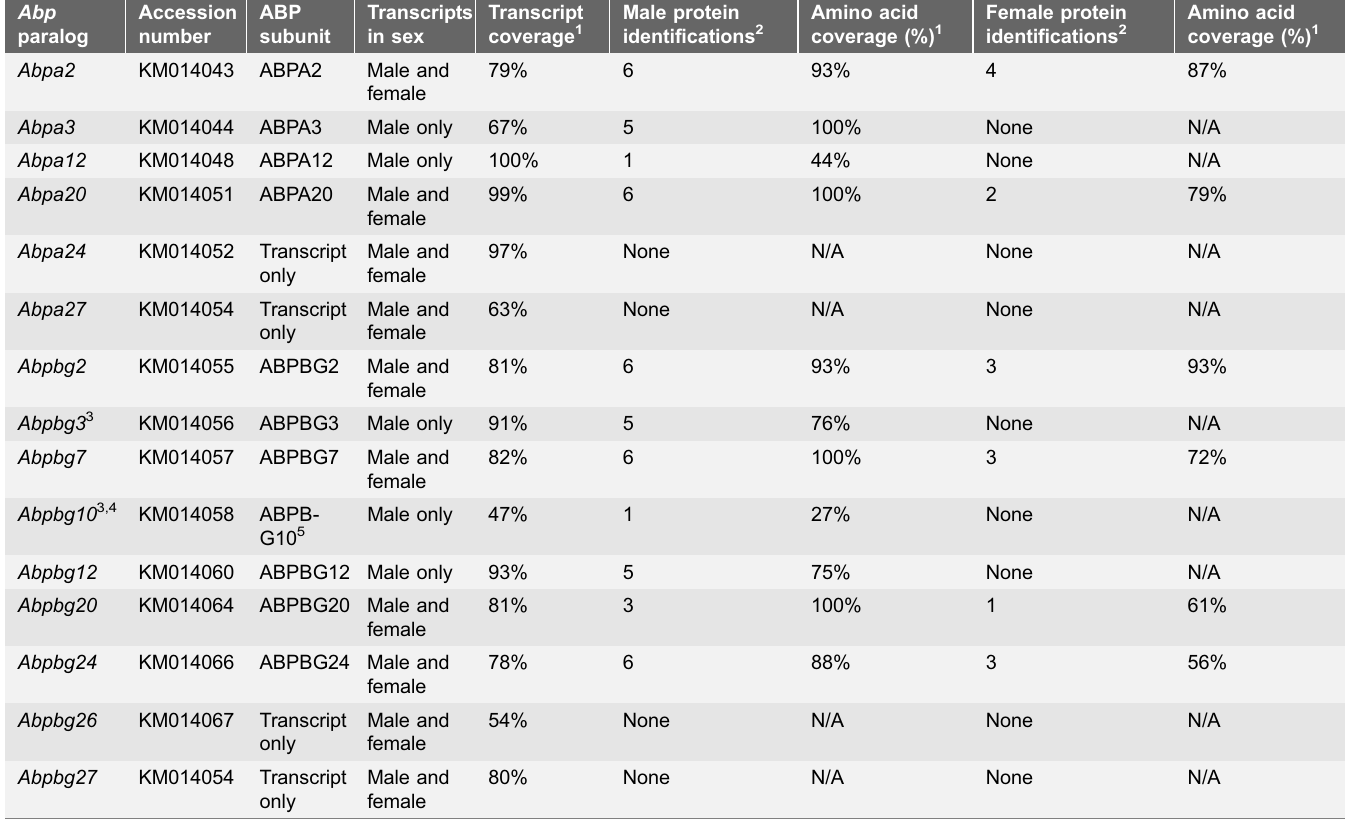
Table 1. Transcriptome (lacrimal glands) and proteome (tears) identification of Abpa and Abpbg subunit